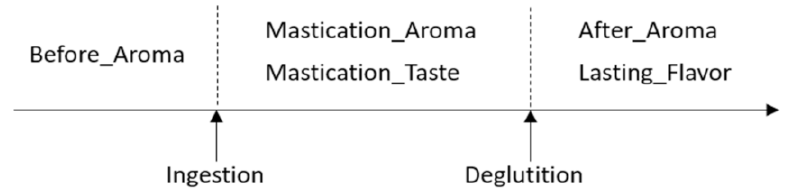
Figure 2. Diagram of sensory evaluation for cheese aroma intensity scores and related